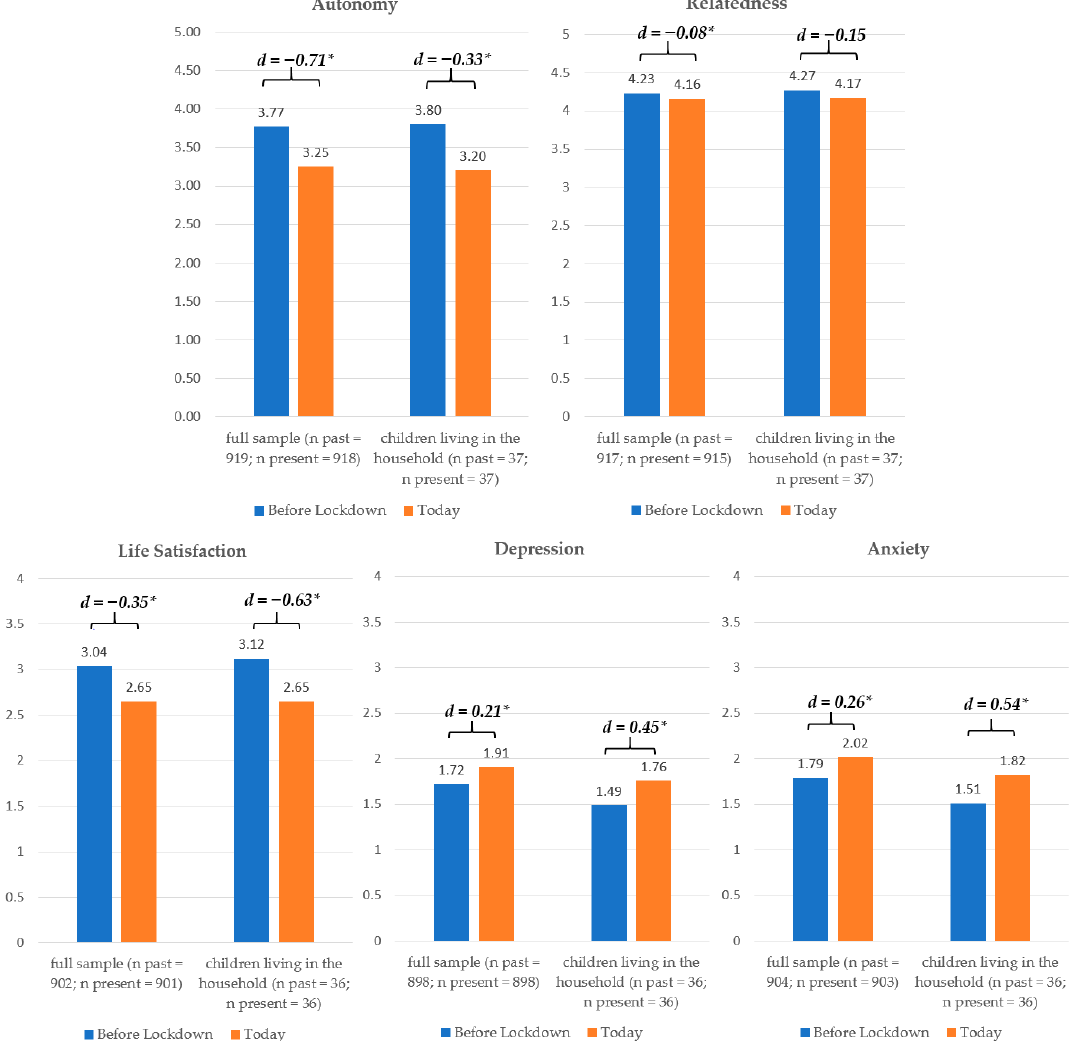
Figure 3. Differential Changes in the Full Sample and for People with Children Living in Their Household. d = Cohen’s d (effect size), * p < 0.05.